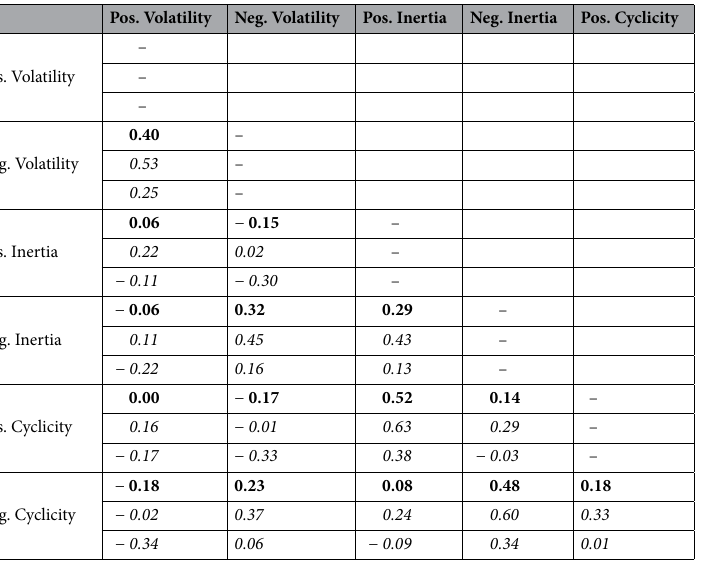
Table 1. Bayesian estimates of correlations among measures of daily positive and negative affective variability, including volatility (intra-individual standard deviation), inertia (strength of first order autoregressions), and cyclicity (longest order from 0 through 7 with a significant autoregression). Measures were calculated separately for positive (Pos.) and negative (Neg.) affect. Numbers in bold indicate the median of the posterior distribution for Pearson’s r , which is the most likely r value, while numbers in italics indicate the upper and lower bounds of the 95% posterior credible interval, which is the range in which there is a 0.95 probability that the r value